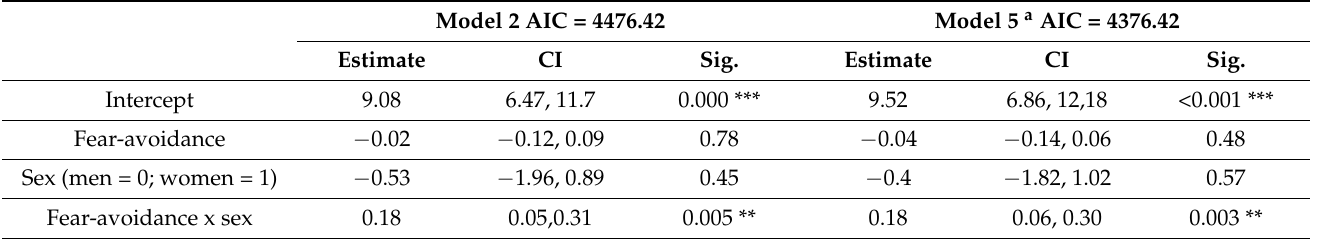
Table 2. Unadjusted and adjusted model regarding sex differences in the association between fear- avoidance and pain intensity.